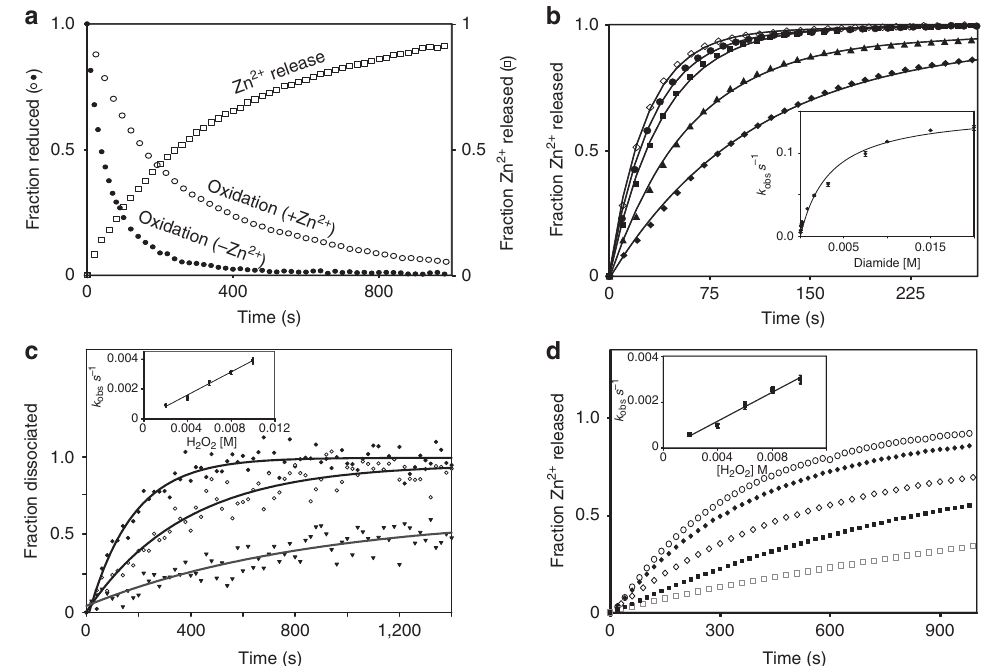
Figure 4 | Zinc release is the rate-limiting step in RsrA oxidation. Experiments were conducted at 25 (cid:2) C in 50mM Tris (pH 7.5) buffer containing 100mM NaCl. ( a ) Oxidation of the RsrA– s R complex on treatment with diamide under second-order conditions (25 m M). The fraction of reduced RsrA was determined by the change in diamide absorbance at 320nm (Supplementary Fig. 2a) in the presence and absence of bound zinc. Zinc release was monitored at 500nm using the PAR assay. The two methods showed good agreement for the bimolecular rate constant for diamide-induced oxidation of RsrA red .Zn 2 þ (183 ± 6 and 195 ± 11M (cid:2) 1 s (cid:2) 1 , respectively). ( b ) Zinc release from the RsrA red .Zn 2 þ – s R complex (2 m M) on treatment with increasing concentrations of diamide under pseudo-first-order conditions monitored by the PAR assay; 25 m M (filled diamonds), 50, 100, 150 and 200 m M (open diamonds). Inset shows variation of k obs with diamide concentration (with associated error bars). Data were fitted to the Michealis–Menten equation, with fitted parameters of K 1 ¼ 0.7mM and k 2 ¼ 0.15s (cid:2) 1 (Supplementary Fig. 2b). The corresponding bimolecular rate constant ( k 2 / K 1 ¼ 214M (cid:2) 1 s (cid:2) 1 ) is